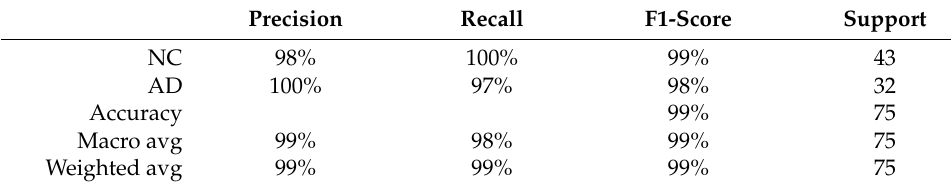
Figure 6. Confusion matrix obtained on the test dataset with Resnet50-Softmax. Table 4. Resnet50-Softmax experiment results with the ADNI dataset.